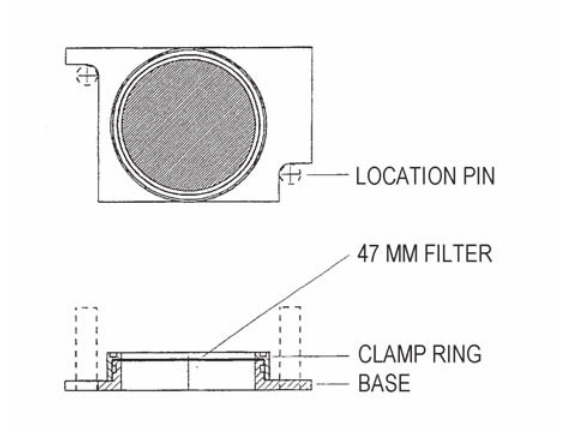
Fig. 7 47 mm filter holder.